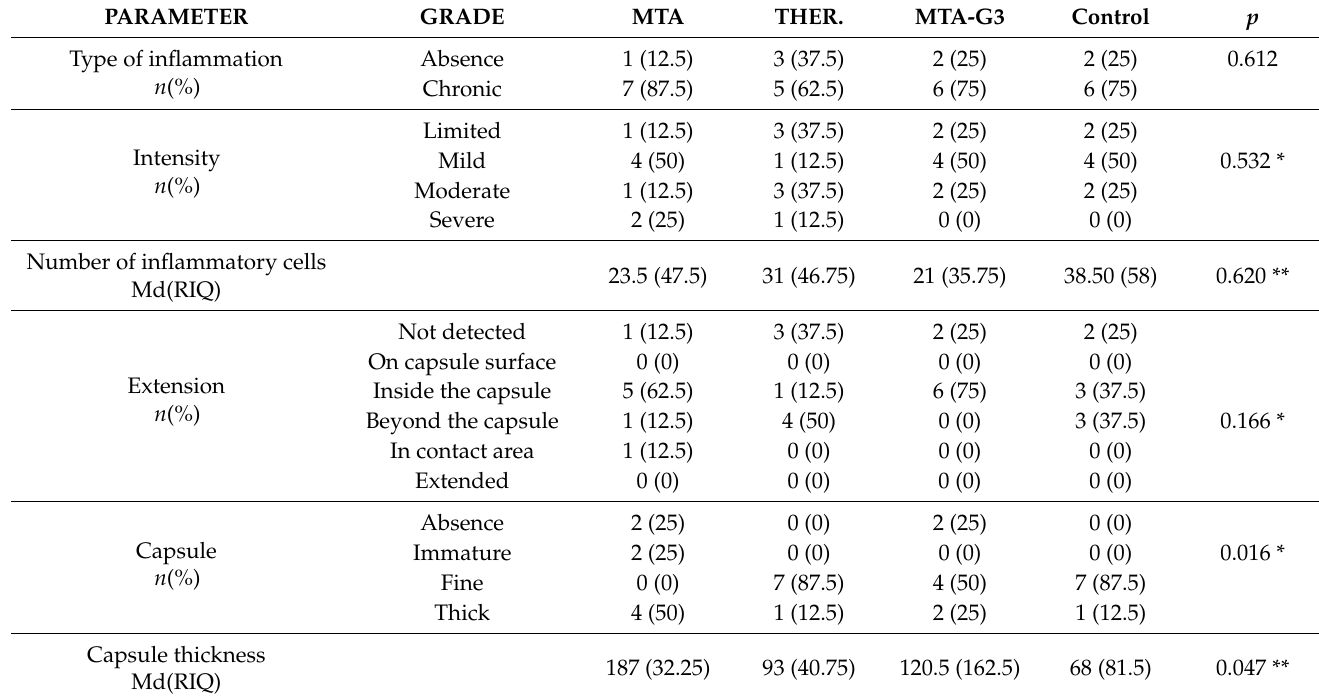
Table 5. Qualitative variables MTA, Theracal and MTA-G3, 30